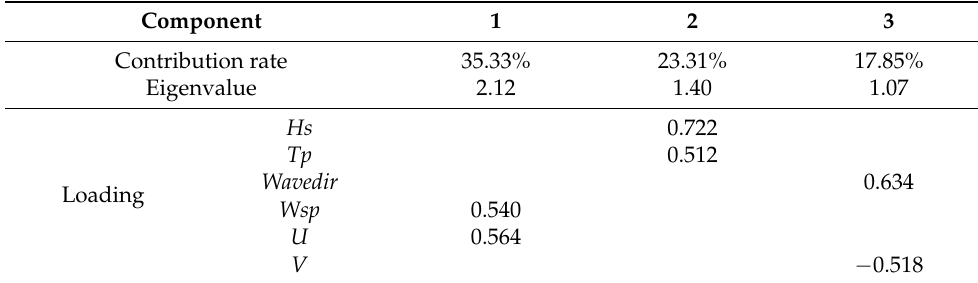
Figure 3. The cumulative contribution rate of the principal components and their corresponding eigenvalues. The first three components present an eigenvalue higher than 1. Only these are considered in further analysis. Table 2. Factor loadings of the PCA. Higher correlations exceeding 0.5 are